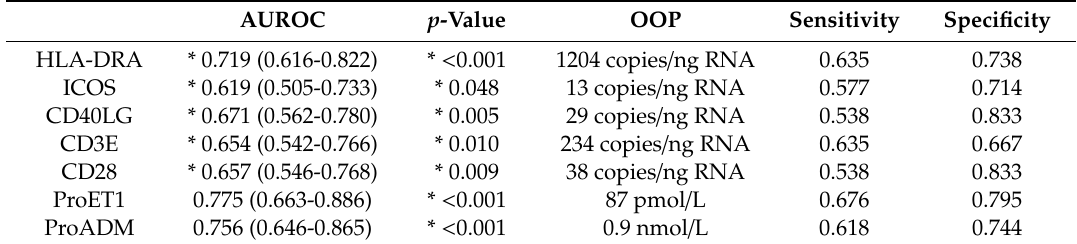
Table 4. Areas under the receiver operating curve for assessing the performance of gene expression levels and biomarkers and their optimal operating points to rule out organ dysfunction.